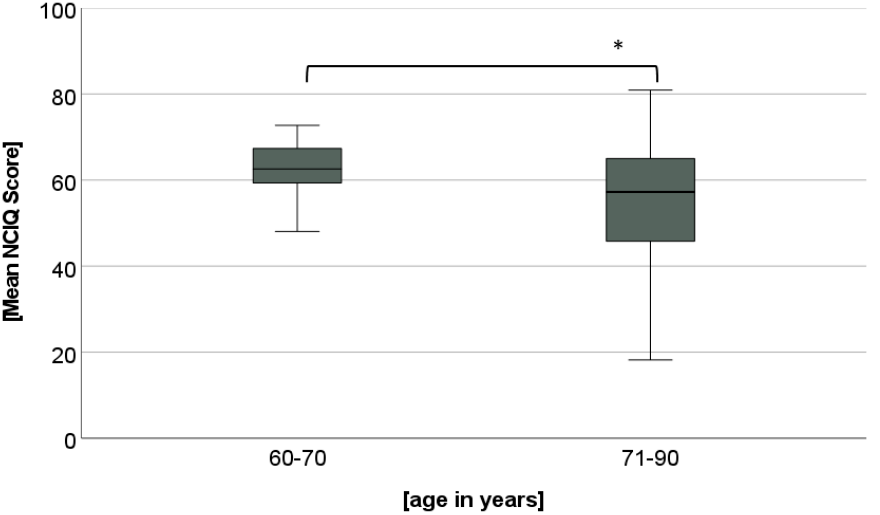
Figure 2. Mean scores of the Nijmegen Cochlear Implant Questionnaire (NCIQ) for each subgroup. Small circles with number indicate outliers. * means significant differences p ≤ 0.05.